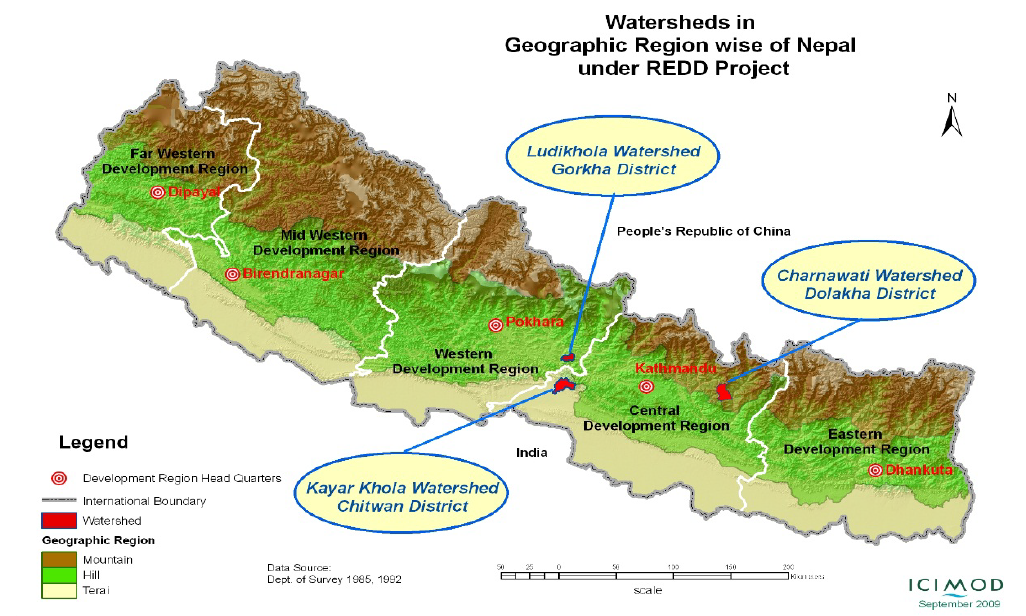
Figure 1. Location of project sites in the three watersheds in